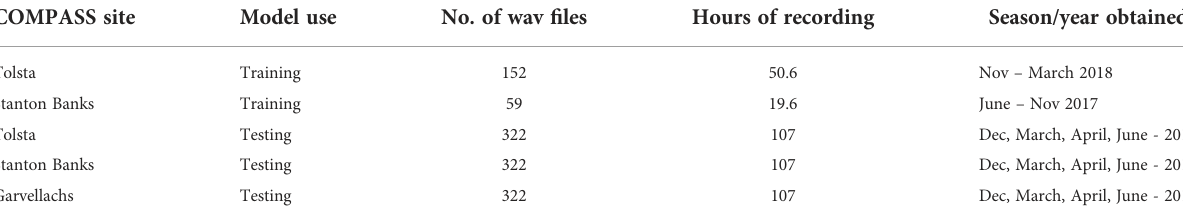
TABLE 3 Contribution of PAM fi les from COMPASS to model development.